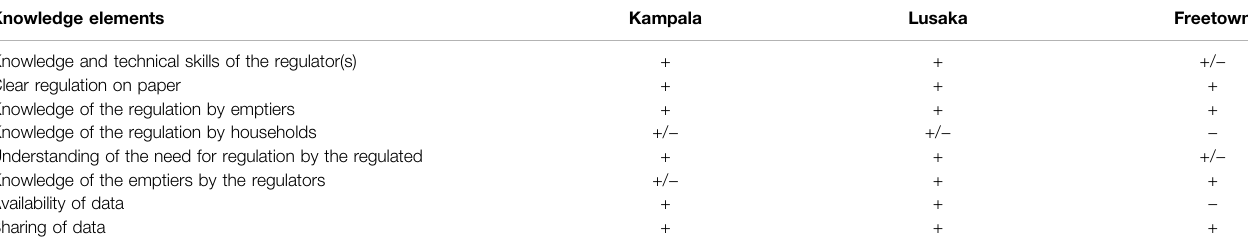
TABLE 4 | Barriers and enablers for knowledge from